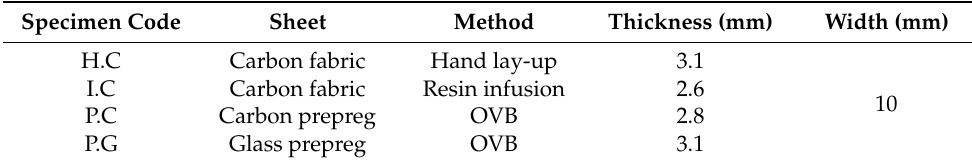
Table 2. Type of CFRP/GFRP grid